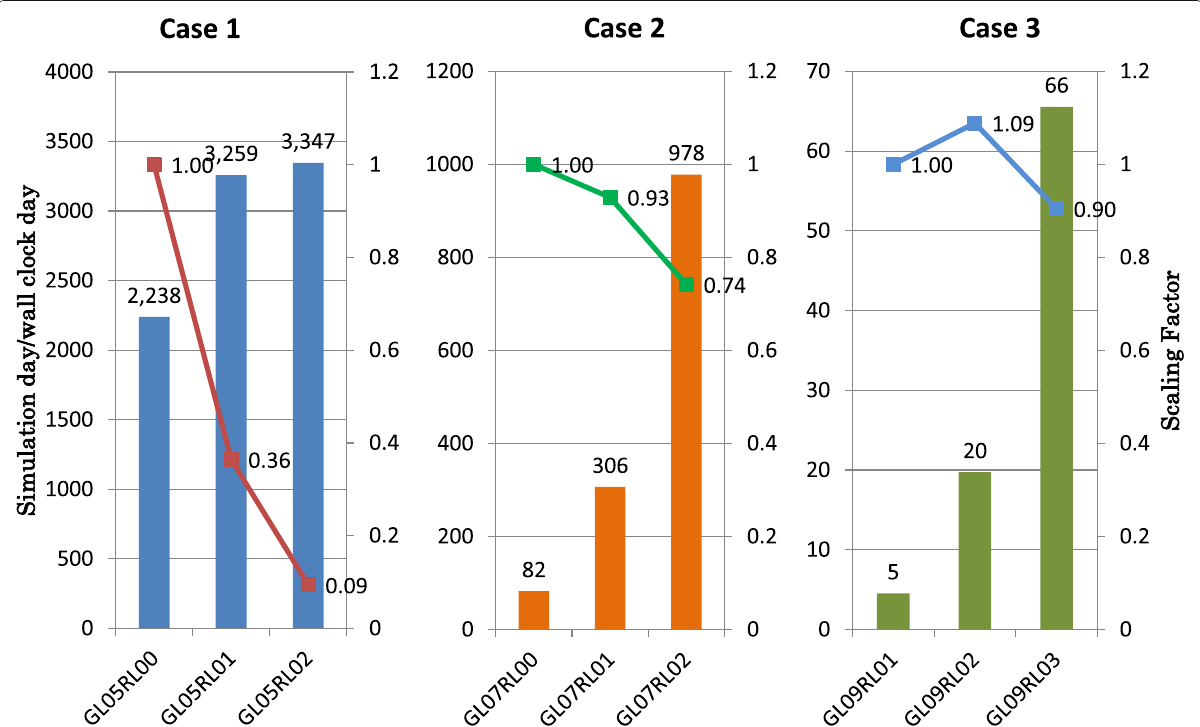
Fig. 7 Results of performance measurement on NICAM–COCO coupling. Bar graph is the number of days that can be simulated in 1 day’s calculation. Line graph is a scaling